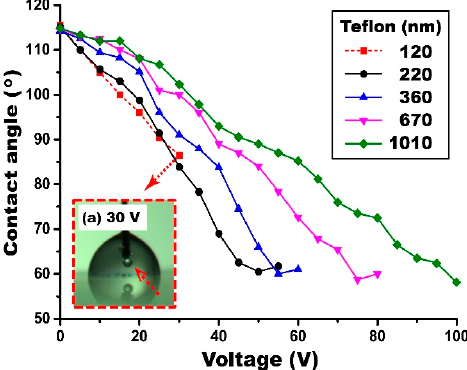
Figure 9. Thickness effect of the dip-coated Teflon layer on static EWOD performance. For all experiments, the gel layer was held fixed at 1.19 μ m, while varying the Teflon layer thickness. A thin Teflon layer allows a high capacitance and thus the same angle modulation is achieved at a lower voltage than other thick layers. The inset shows bubble generation due to electrolysis when the Teflon layer is 120 nm thin at 30 V.